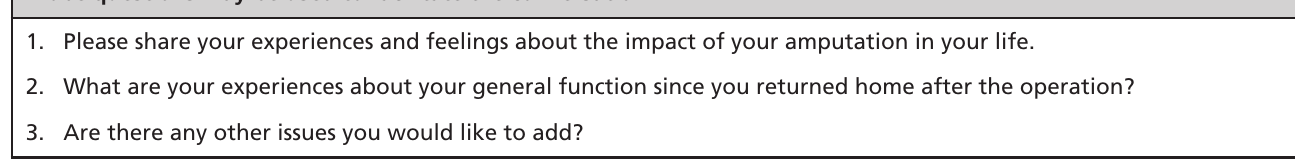
Probe questions may be used to facilitate the conversation. 1. Please share your experiences and feelings about the impact of your amputation in your life. 2. What are your experiences about your general function since you returned home after the operation? 3. Are there any other issues you would like to